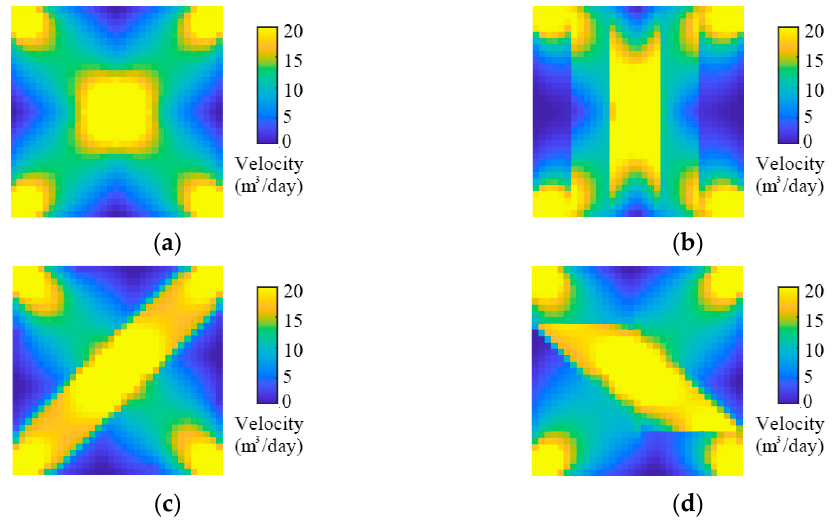
Figure 11. Lateral velocity profiles of synthetic models with different permeability strips. ( a ) Homo- geneous distribution; ( b ) vertical distribution; ( c ) diagonal distribution; ( d ) block-like distribution.